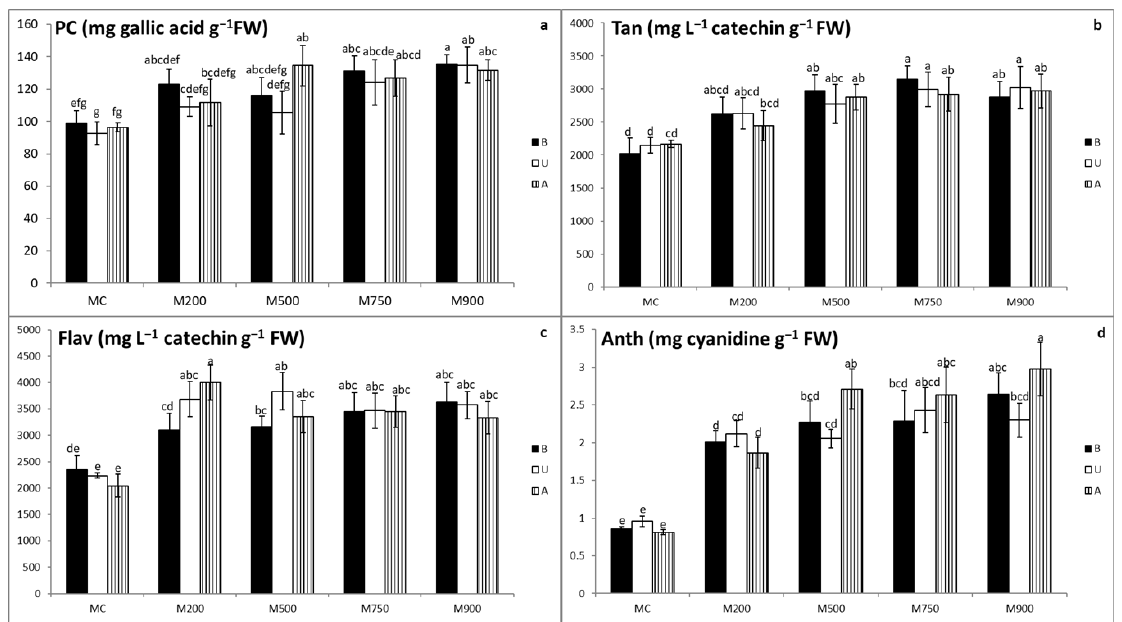
Figure 2. Phenolic compound, PC ( a ), tannin, Tan ( b ), flavonoid, Flav ( c ) and anthocyanin, Anth ( d ) concentrations in the leaves of three different miscanthus cultivars (B, U, and A) cultivated in soils with gradient TE concentration (MC-control, M200, M500, M750, and M900). Values are presented as means ± SD. Different letters refer to significant differences between plants (Turkey HSD test, n = 5, p ≤ 0.05).